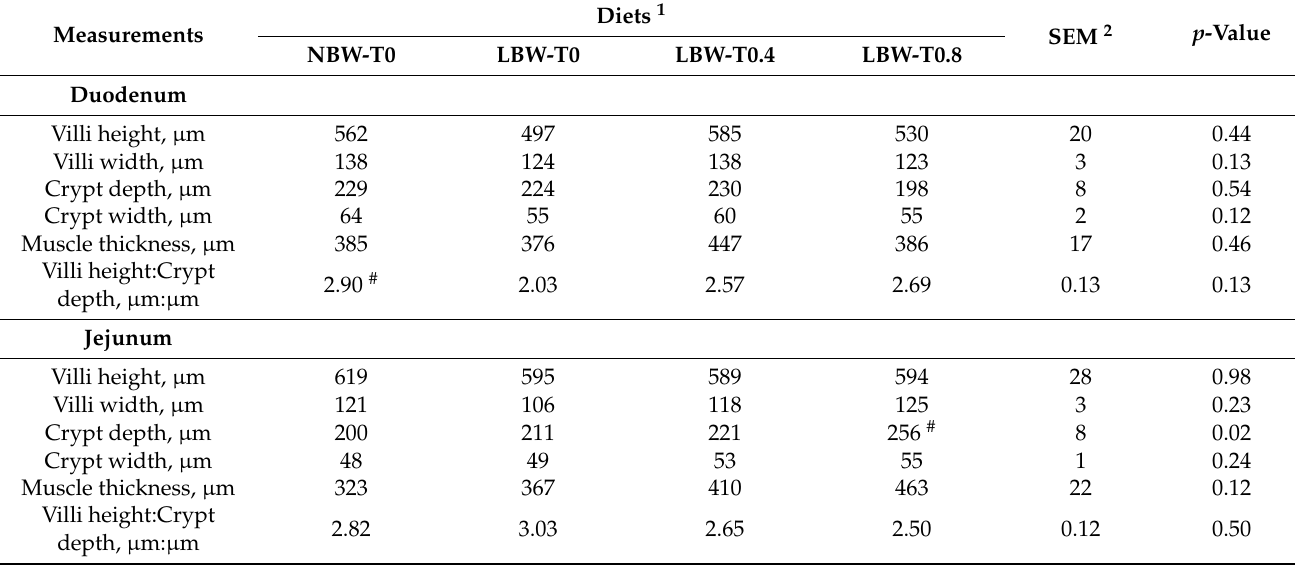
Table 2. Effect of dietary L-tryptophan supplementation on the intestinal morphology of low-birthweight neonatal pigs. Measurements